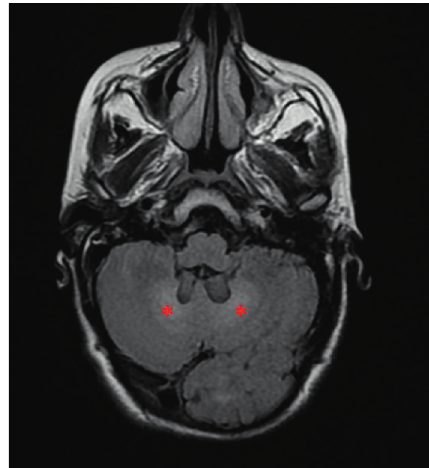
Figure 3: Axial image of brain MRI showing bilateral T2 hyper- signal of the serrated nuclei (asterisks).